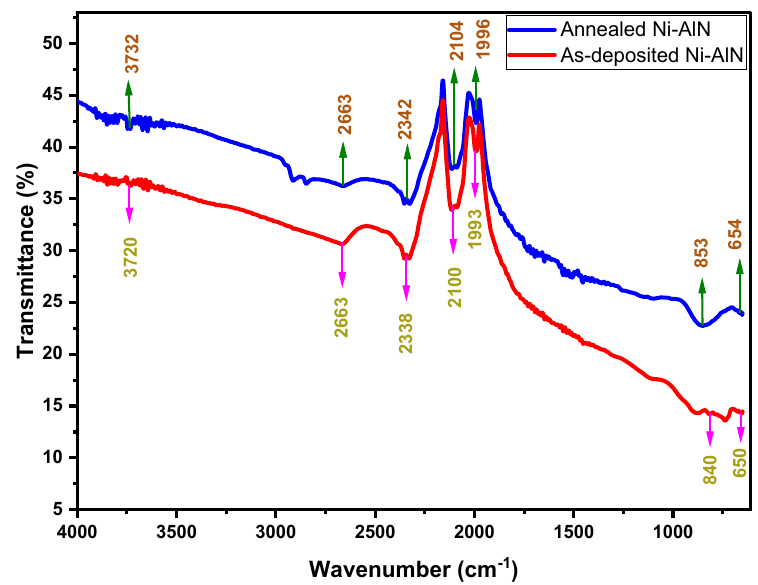
Figure 5. FTIR spectrum of the Ni: AIN thin film.